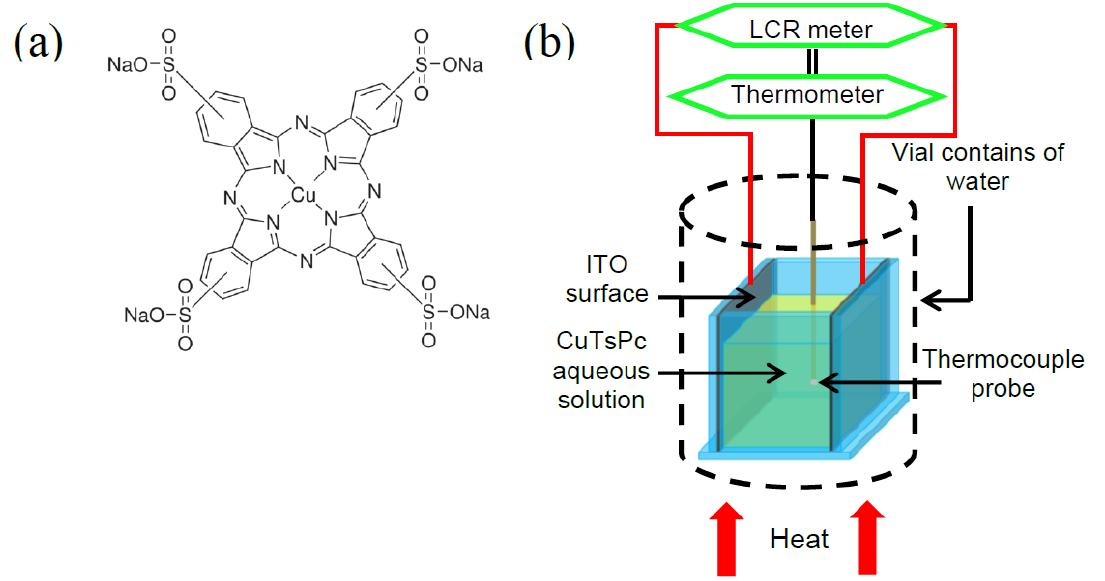
Figure 1. Molecular structure of copper (II) phthalocyanine-tetrasulfonic acid tetrasodium